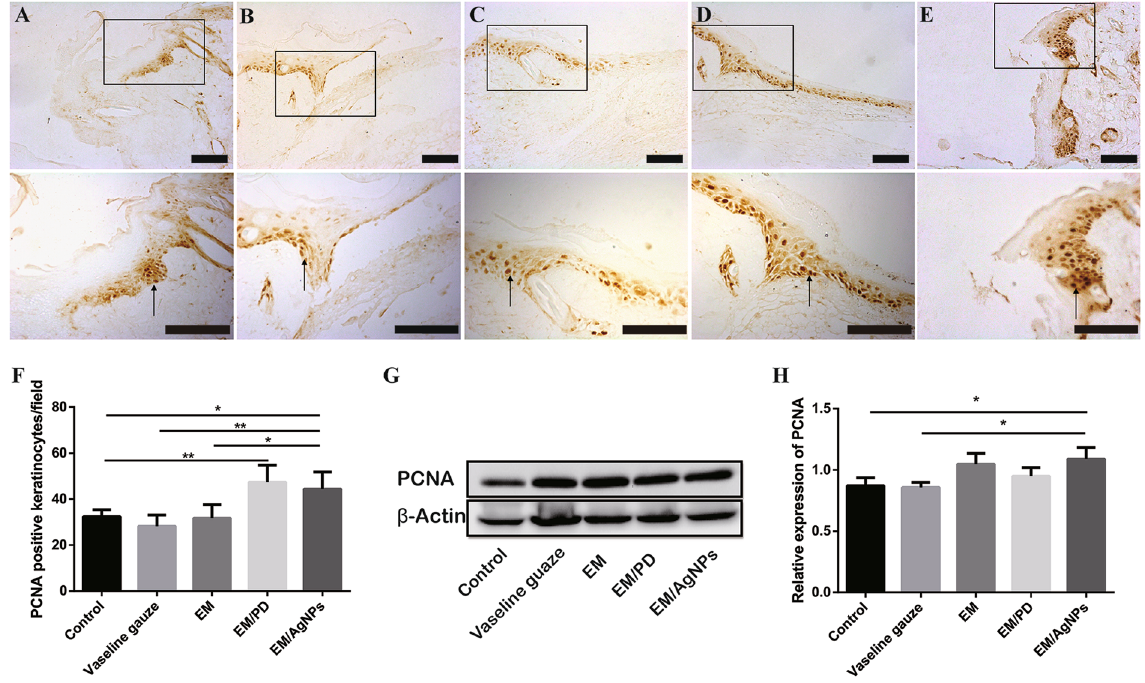
Figure 11. The detection of PCNA in wound tissue at day 3 post-surgery. Representative images of immunohistochemical staining of PCNA in the ( A ) Control, ( B ) Vaseline gauze, ( C ) EM, ( D ) EM/PD and ( E ) EM/AgNPs groups. The rectangular insets indicate magnified areas, and the black arrows indicate PCNA- positive keratinocytes. ( F ) The number of PCNA-positive keratinocytes per field in newly generated epidermis. The values are shown as the mean ± SD (n = 5). ( G ) The levels of PCNA protein in the full-thickness wound tissues, as detected by Western blotting, and ( H ) the optical density values of the PCNA bands. The values are shown as the mean ± SD (n = 3). Scale bars: 100 μ